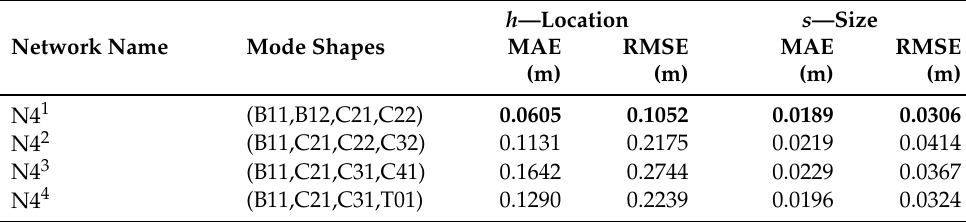
Table 7. The results of the identification of { h , s } on the basis of four mode shapes.